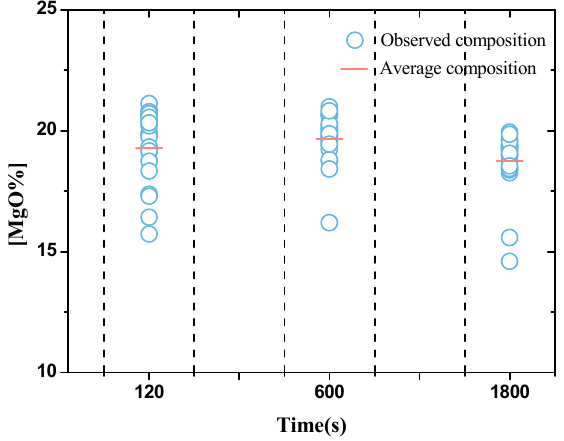
Figure 1. Composition of inclusions in steel with holding time.